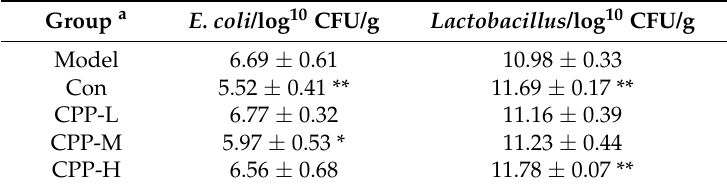
Table 2. Effects of CPP on the number of E. coli and Lactobacillus in cyclophosphamide-treated mice.